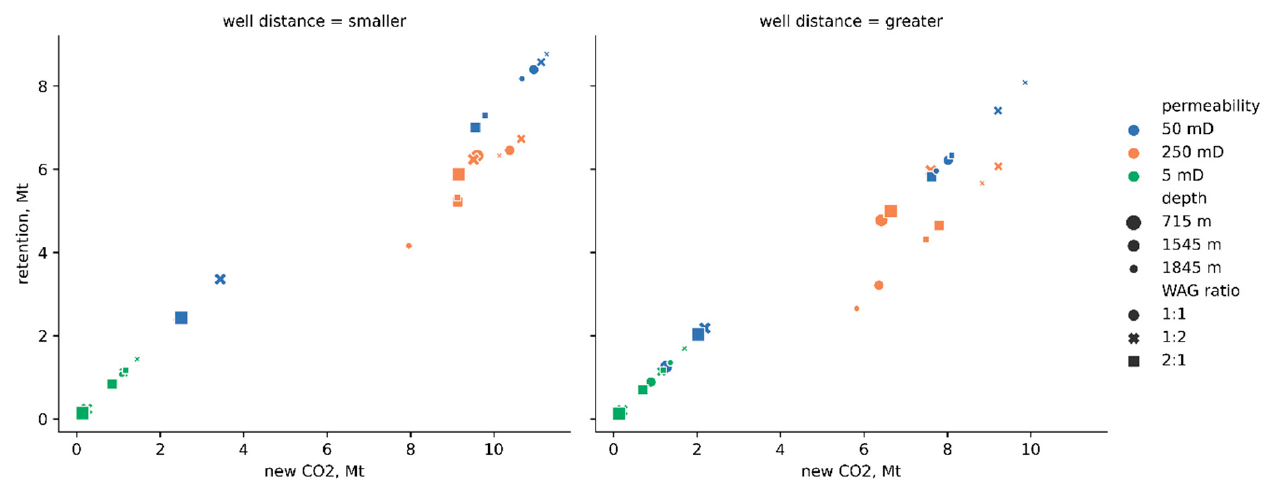
Figure 7. Retention versus new CO 2 after 15 years of EOR.